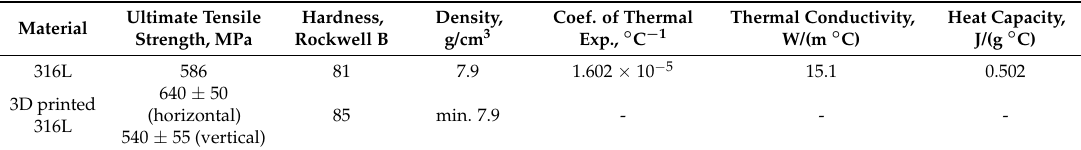
Table 2. Comparison of physical properties between 3D-printed [29] and traditional 316L [30] stainless steel.